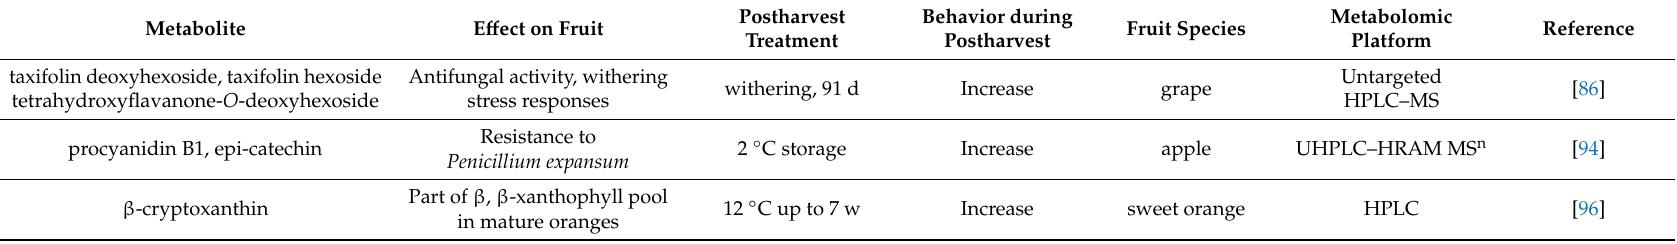
Table 2. Secondary metabolites (polyphenols and carotenoids) identified as putative biomarkers by metabolomic profiling studies to assess fruit quality changes during postharvest storage. d: day; w: weeks; UHPLC–HRAM MS n : ultra-high-performance liquid chromatography coupled to high resolution multiple-stage mass